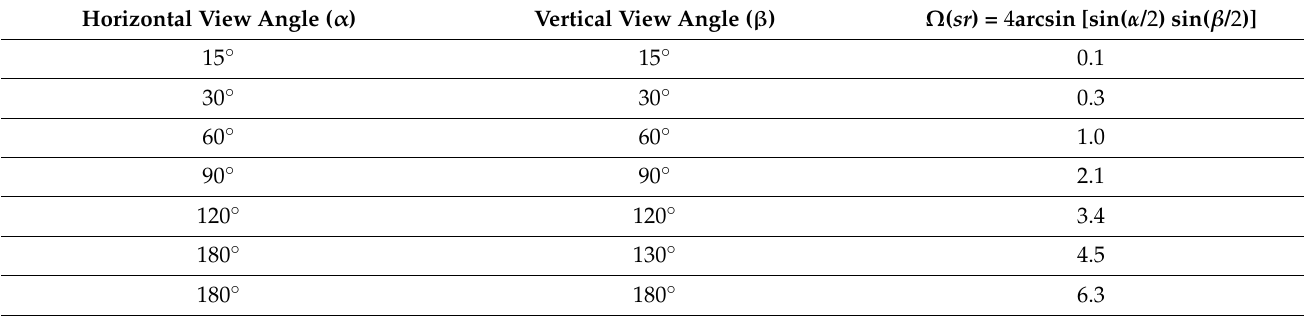
Table 2. Calculated solid angles for different vision fields of human